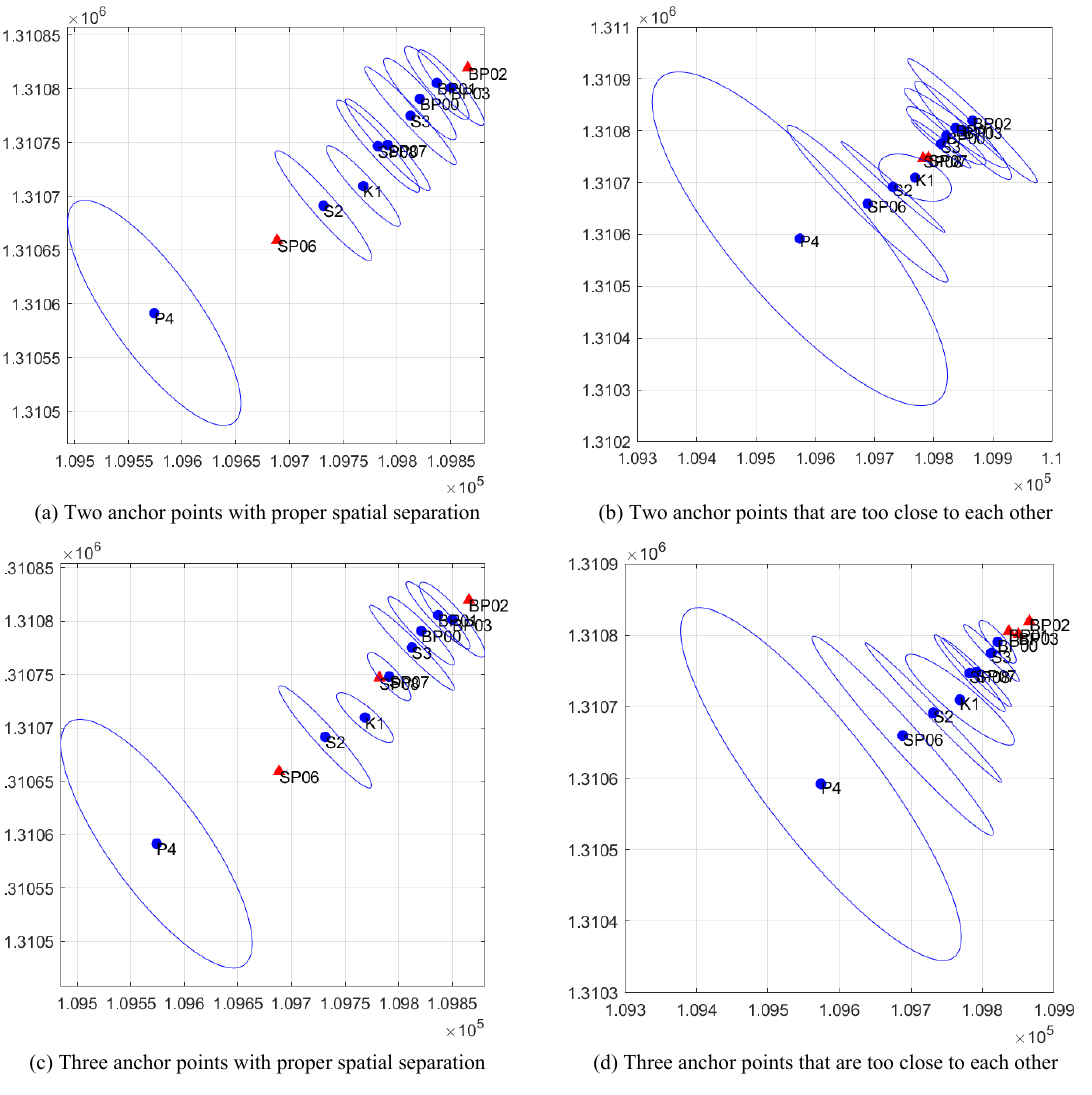
Figure 5 . Impact of the spatial distribution of anchor points on a corridor distributed swarm